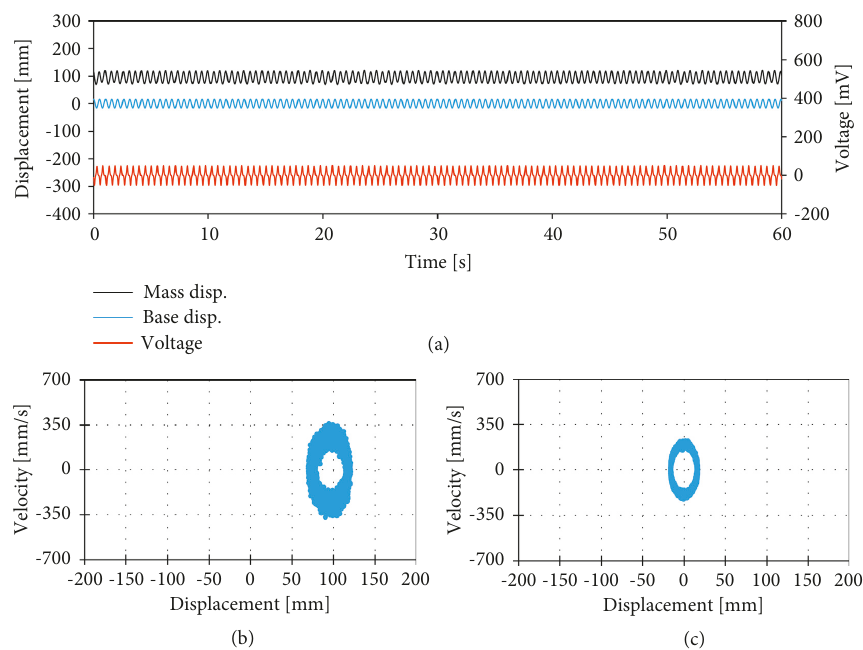
Figure 10: Measured results for response vibration displacement and vibration power generation for vibration with a periodic signal at 2.00Hz. (a) Response vibration displacement results. (b) Diagram of displacement vs. velocity of vibration for the mass block. (c) Diagram of displacement vs. velocity of vibration for the